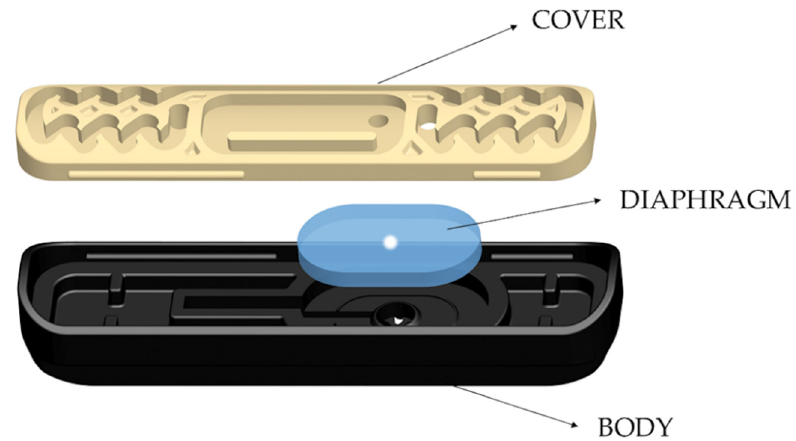
Figure 2. Diagram of an emitter showing its three components: body, silicon diaphragm and cover. The water flows from the body to the cover, passing through the diaphragm. Illustration provided by Teresa Munuera (Sistemas AZUD).